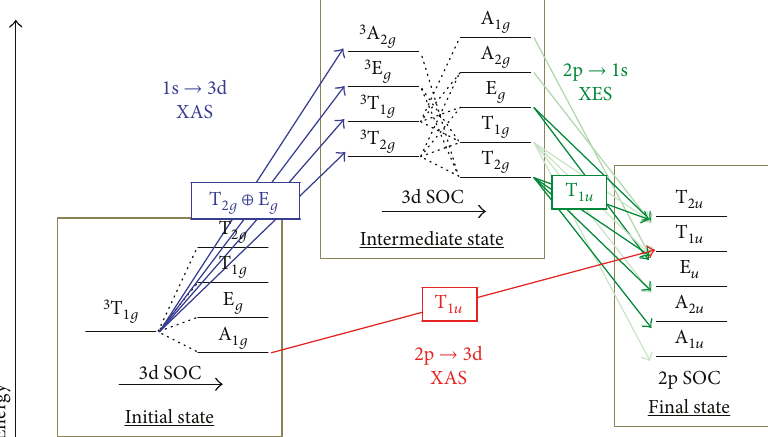
Figure 35: Multielectronic term scheme for Mn 3+ (3d 4 ) in low spin comparing the 1s2p RIXS and direct 2p XAS pathways. Where SOC is included, the spin multiplicity is